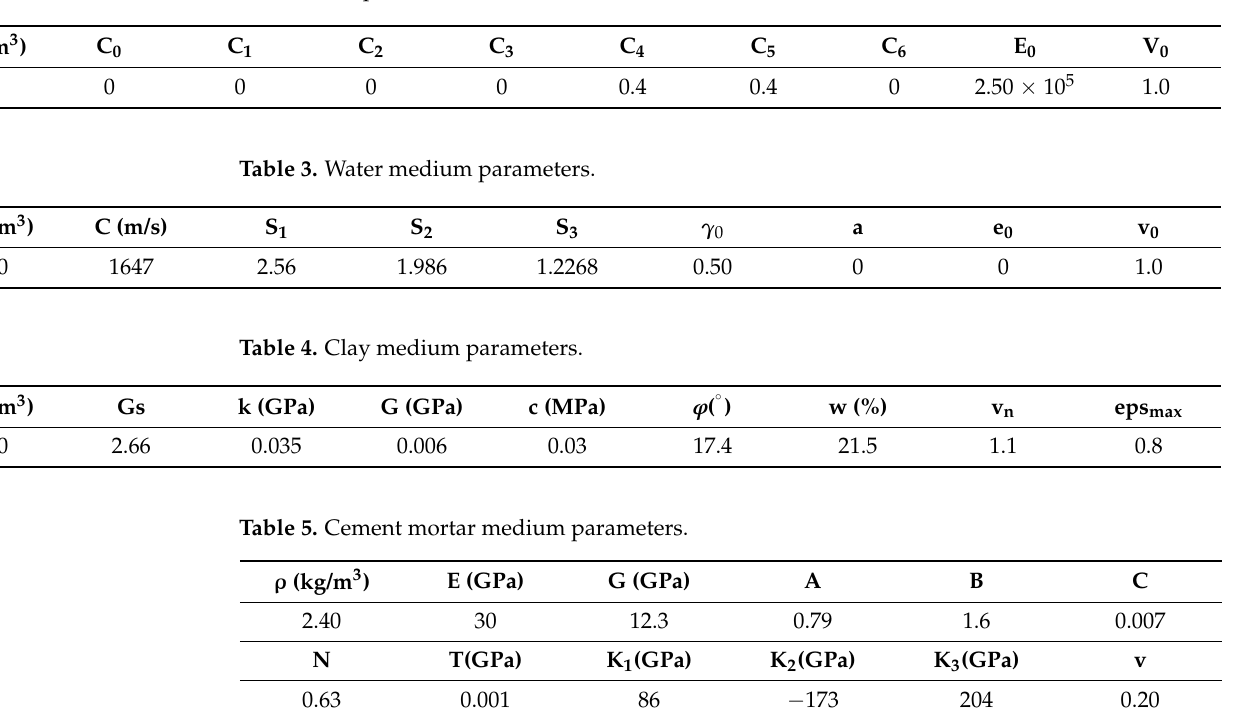
Table 2. Air parameters.